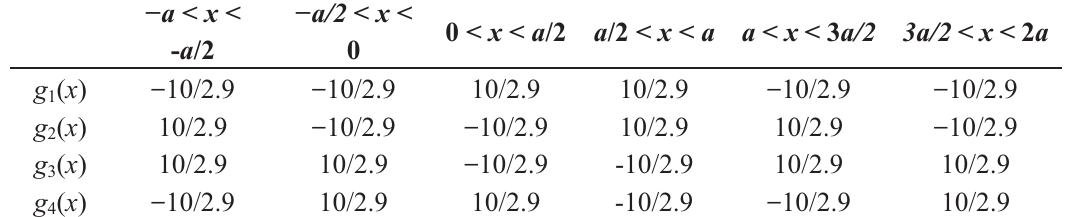
( x ) = dL / dx , with respect to the position, x (mod 2 a ). k k